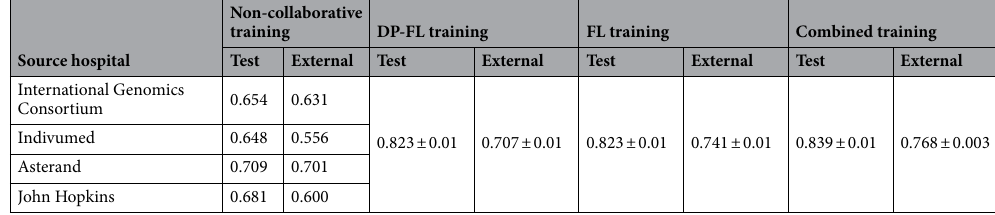
Table 4. Evaluation of collaborative and non-collaborative learning on Test and External Datasets using DP-SGD, achieving privacy parameter ε = 2 . 90 for δ = 0 . 0001. For FL and combined training we report the mean accuracy and standard deviation across the client’s test datasets. On the external dataset we ran the experiments using three random initializations, and report the mean accuracy and standard deviation across